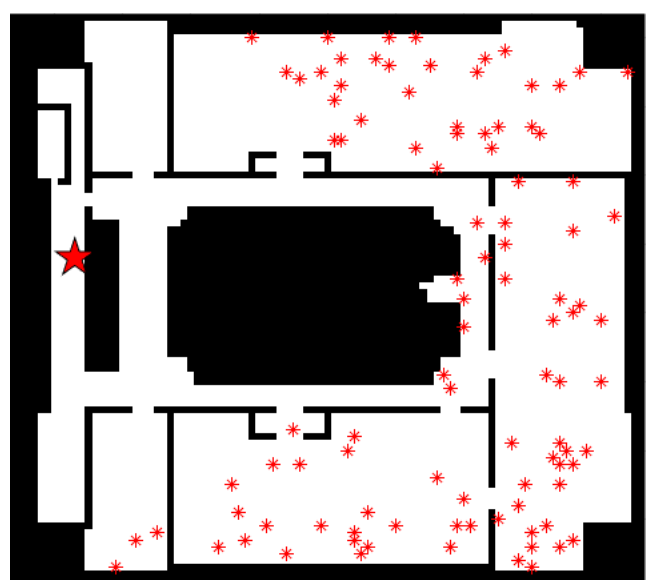
Figure 10. The 100 generated destinations (star) and the starting position (pentagram) on the map.